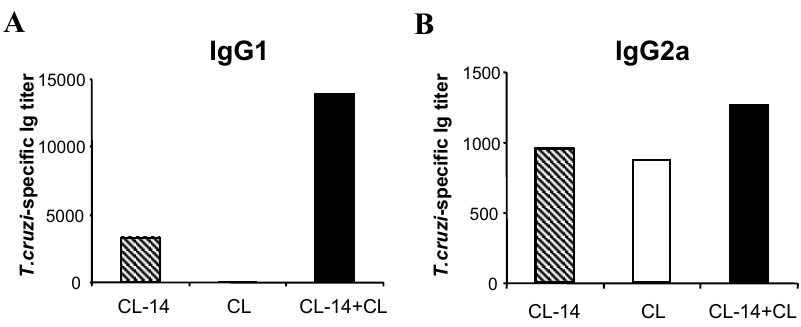
Fig. 2 – Production of IgG1 and IgG2a by mice inoculated with CL-14 clone and challenged with CL strain trypomastigotes. BALB/c mice were inoculated with 107 purified CL-14 trypomastigotes. Groups of normal littermates and CL-14-inoculated mice were challenged with 10 4 CL strain trypomastigotes 6 weeks later. Three mice from each group (CL or CL-14+CL) and from a group that received only the inoculation of 10 7 trypomastigotes of CL-14 clone (CL-14) were bled two weeks after challenge. Pools of plasma were assayed by ELISA to determine the T. cruzi -specific IgG1 (A) and IgG2a (B) titers, as described in Materials and Methods. Similar results were obtained in two independent